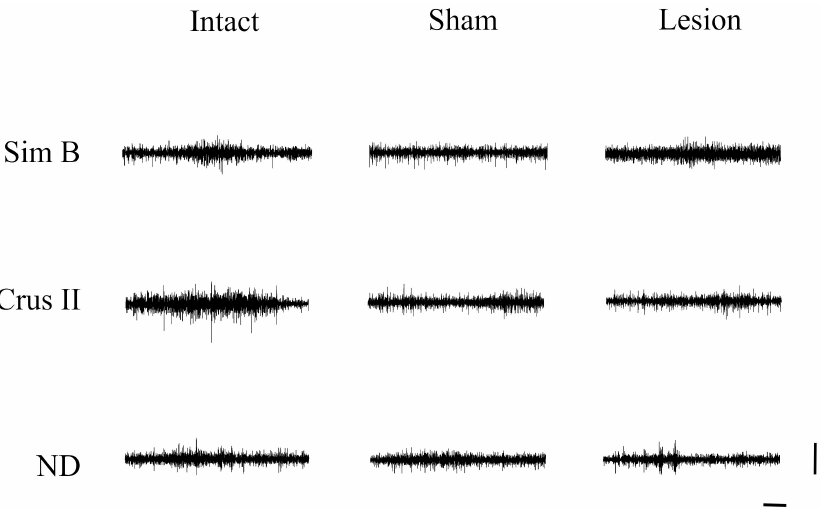
Figure 3. Representative traces of three-second multiunit activity were obtained during horizontal exploration of animals from intact, sham, and lesion groups in the Sim B, Crus II lobes, and the dentate nucleus. Horizontal calibration: 500 ms. Vertical Calibration: 2 mV.